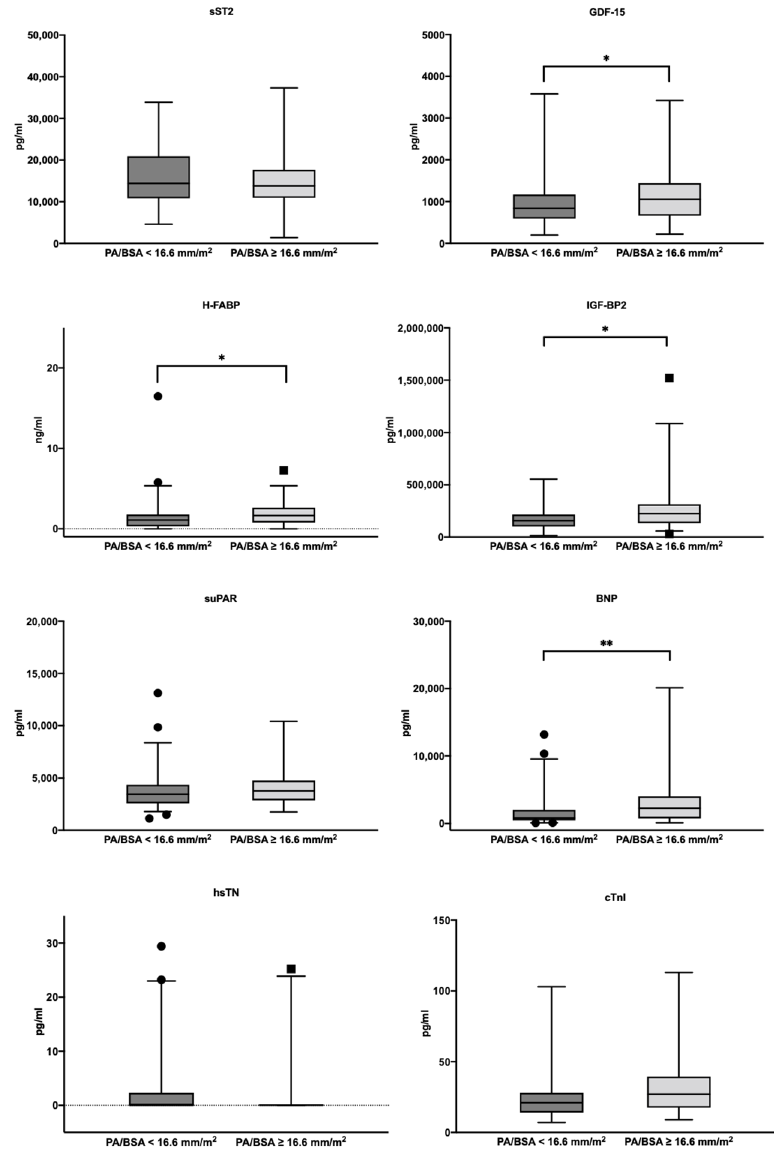
Figure 3. Serum concentrations of sST2, GDF-15, H-FABP, IGF-BP2, suPAR, BNP, hsTN, and cTnI in patients with a PA/BSA value ≥ 16.6 mm/m 2 and with a PA/BSA value < 16.6 mm/m 2 ; ** p ≤ 0.010;